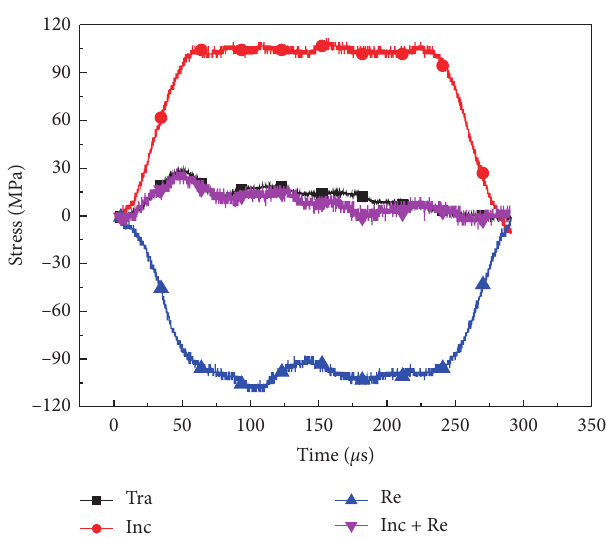
Figure 3: Typical stress equilibrium curves of the